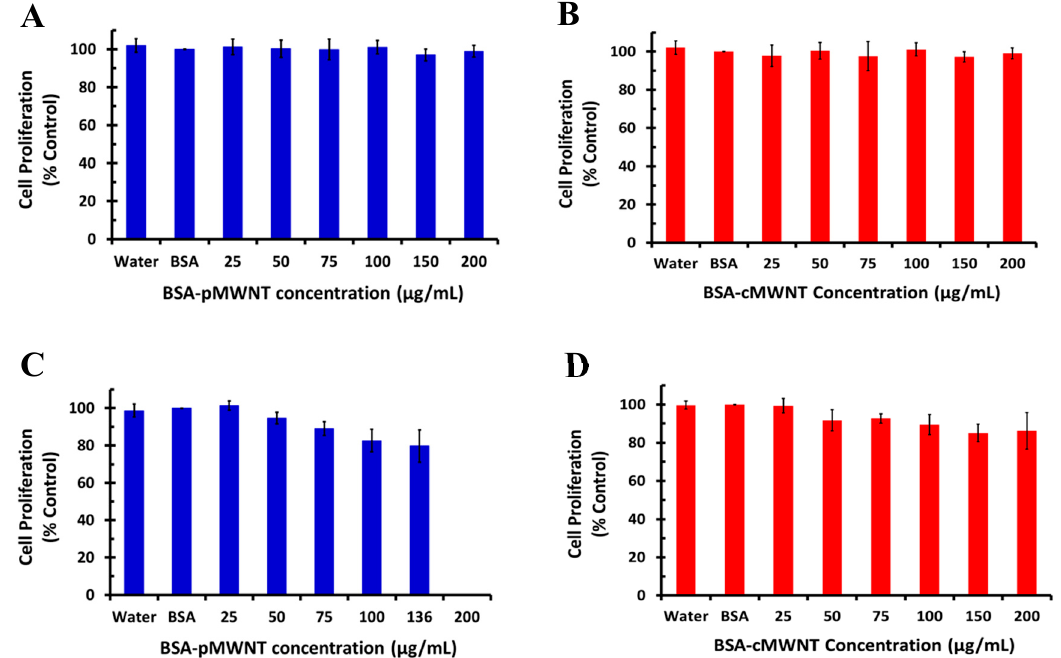
Figure 1. Cell proliferation of RAW 264.7 macrophages cultured with purified BSA-MWNT suspensions prepared with ( A ) 2015-pMWNTs, ( B ) 2015-cMWNTs, ( C ) 2018-pMWNTs, and ( D ) 2018-cMWNTs. MWNTs suspended in a 0.10 mg / mL BSA working solution were mixed with an equal volume of 2X-concentrated medium to produce MWNT concentrations of 0, 25, 50, 75, 100, 150, and 200 µ g / mL, except for the 2018-pMWNTs where the highest MWNT concentration that could be made was 136 µ g / mL. Exposure to deionized water or a BSA working solution (in the absence of MWNTs) were the controls. Equivalent number of cells were seeded in 48-well plates and incubated at 37 ◦ C under standard cell culture conditions for 24 h prior to the experiment. Cell proliferation after incubation with control and test media for 24 h at 37 ◦ C was determined by the crystal violet assay where the proliferation of control cells exposed to the BSA working solution in the absence of MWNTs was set to 100%. All data sets are the mean of quadruple samples in three independent experiments ± the SD. The 24-h proliferation of RAW 264.7 cells incubated with 2015 MWNTs were essentially identical over the course of ~8 months.